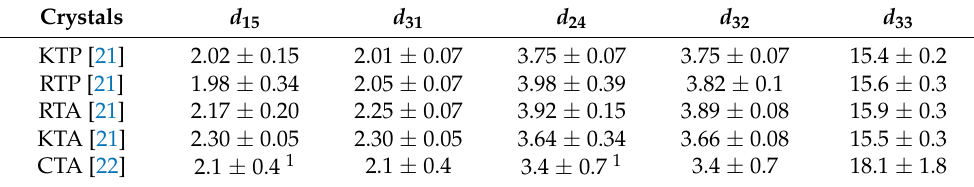
Table 1. Non-zero nonlinear optic coefficients of 5 KTP isomorphs at 1064 nm (in pm/V).